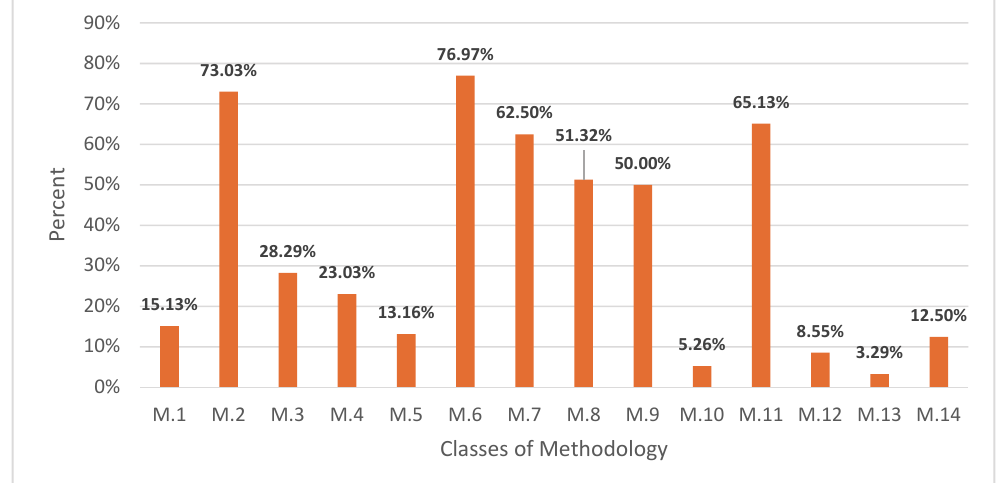
Fig. 10. The proportion of articles in each class of